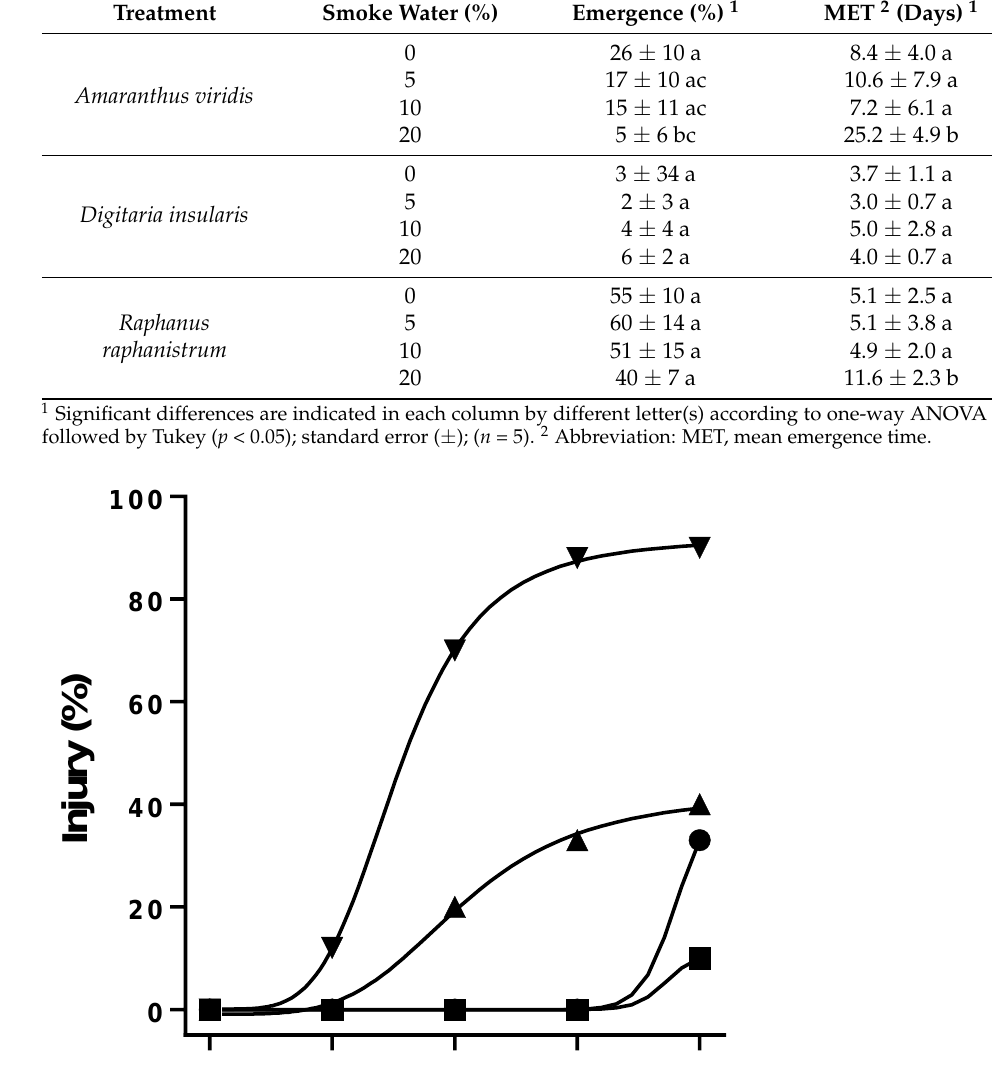
Table 2. Effect of smoke solutions on seed emergence of weeds in a greenhouse.